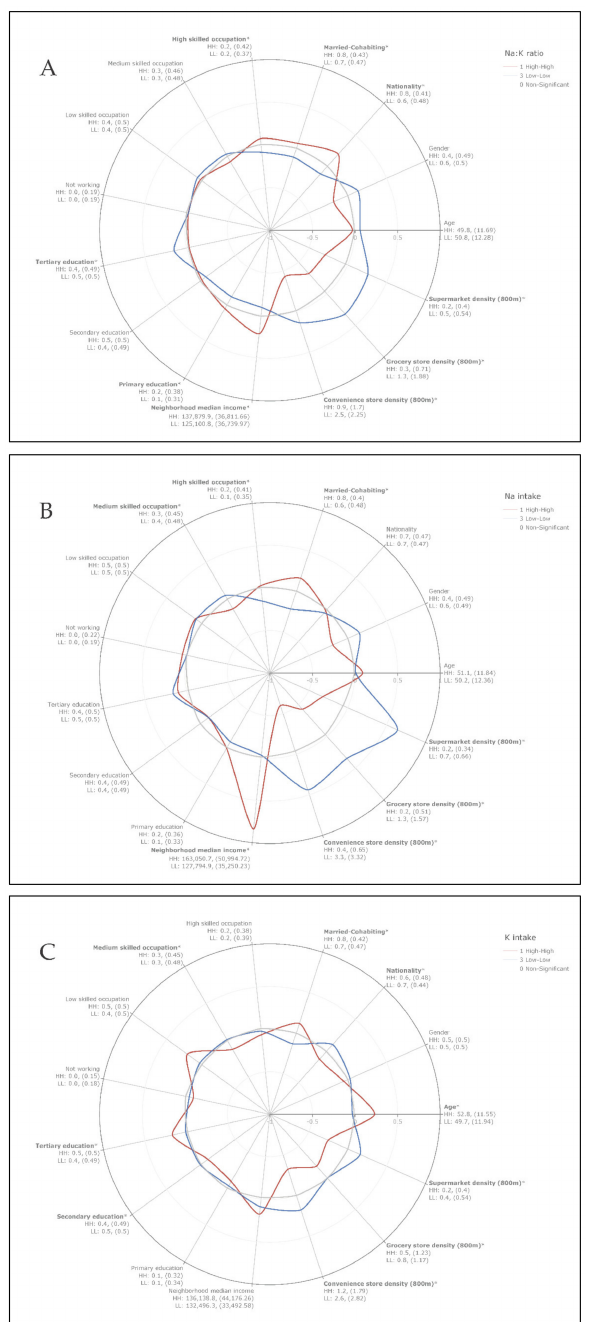
Figure 2. Characterization of local spatial clusters. Radar plot of standardized socio-demographic and food environment characteristics in high-high and low-low spatial clusters for ( A ) Na:K ratio, ( B ) Na intake, and ( C ) K intake. The mean (SD) is provided under each characteristic. High-high class (HH); low-low class (LL). The statistical significance was evaluated using Welch’s t -tests for continuous variables and Fisher’s exact tests for binary variables. * p -value <